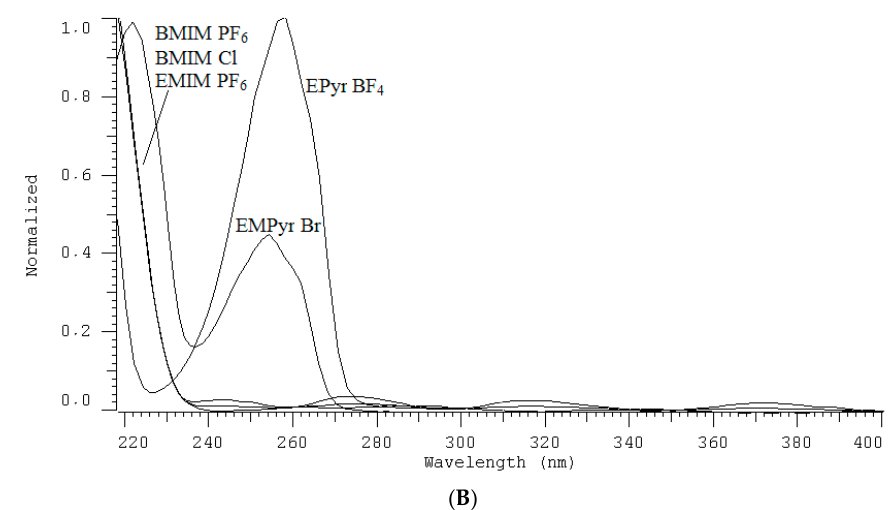
Figure 1. ( A ) Comparison of peaks: a—EMPyr Br, b—BMIM PF6, c—EMIM PF6, d—EPyr BF4 obtained on a Zorbax Extend-C18 column using the mobile phases listed in Table 2; ( B ) UV spectra obtained for the investigated ionic liquids: EMPyr Br, BMIM PF 6 , EMIM PF 6 , EPyr BF 4 .